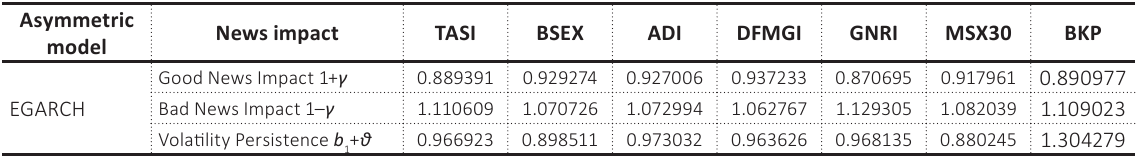
Table 10. Heteroskedasticity